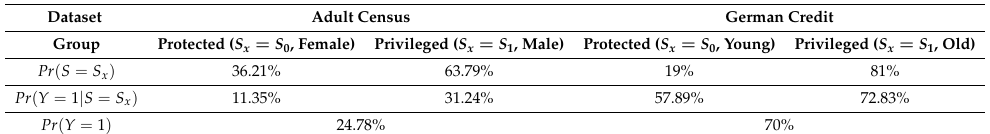
Table 2. Distribution of the different groups with respect to the protected attribute and the decision one for both the Adult Census Income and the German Credit datasets.